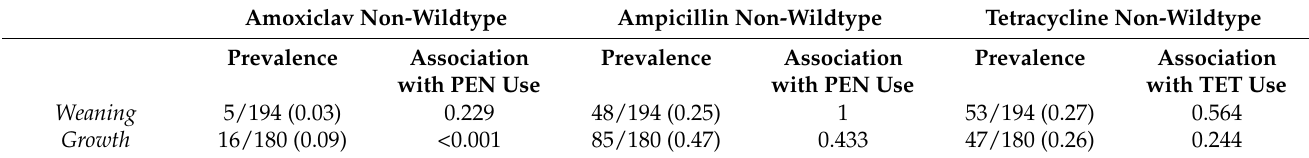
Table 5. Non-wildtype Escherichia coli isolates from Danish mink farms collected during two sampling rounds in 2018. Association between resistance and short-term use of the respective antibiotic drug on farm just prior to sampling ( χ 2 /fisher-test